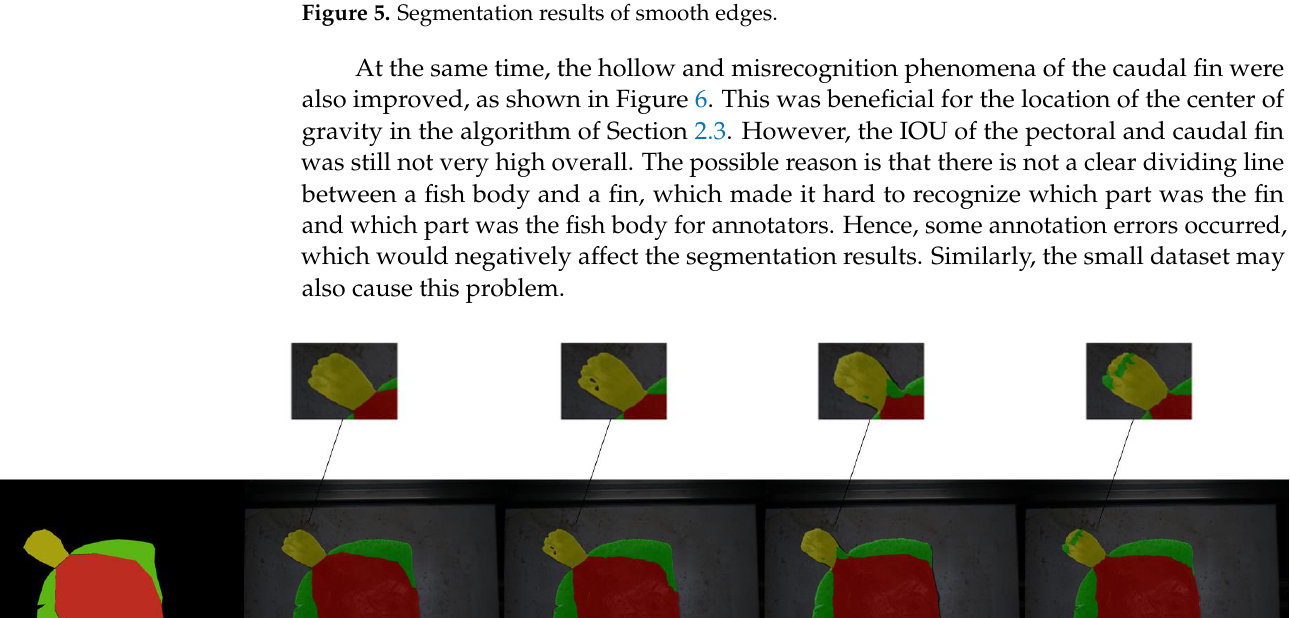
Figure 5. Segmentation results of smooth edges.